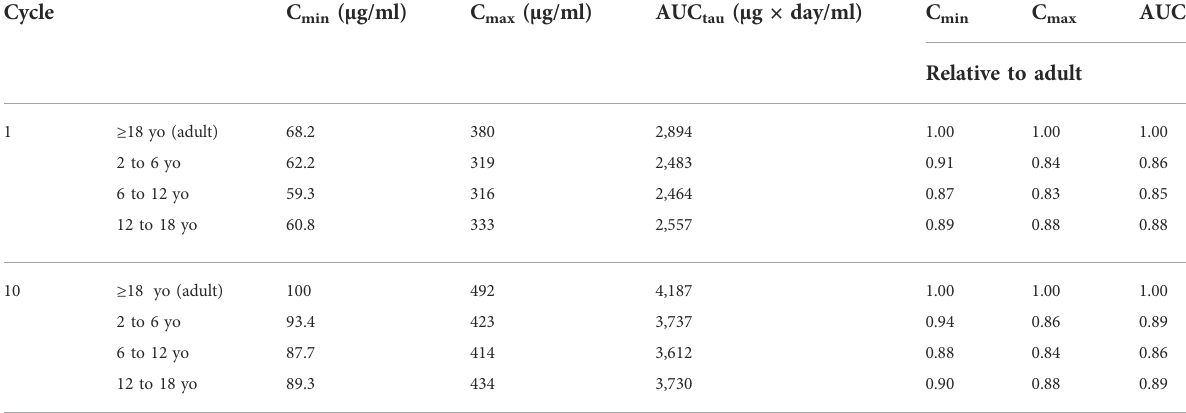
TABLE 2 Predicted geometric mean plasma C min , C max , and AUC tau values for atezolizumab following multiple IV doses of 15 mg/kg atezolizumab Q3W in pediatric subjects and 1,200 mg in adults for Cycle 1 and Cycle 10 (steady state). Relative values of pediatric exposure metrics compared to adults are also